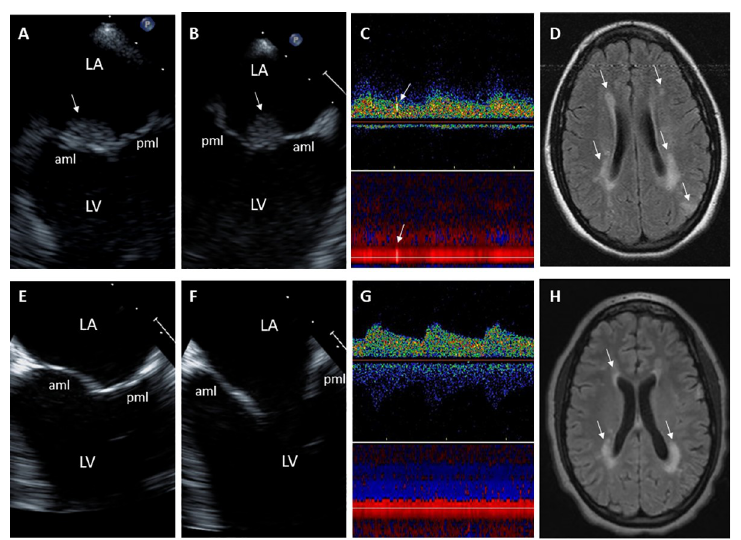
Fig 4. 18-year-old female with Libman-Sacks Endocarditis complicated with acute homonymous hemianopsia, confusional state, and cognitive dysfunction. A,B. These 2-D TEE orthogonal views ( A,B ) demonstrate a large (area of 1.3 cm 2 ), sessile, and oval shaped Libman-Sacks vegetation (arrows) on the atrial side of the anterior mitral leaflet (aml). Associated moderate mitral regurgitation was present. C . Transcranial Doppler of the right middle cerebral artery demonstrates 1 of 4 microemboli (arrows). D . Diffuse weighted imaging of the brain demonstrates bilateral periventricular cerebral infarcts (arrows) for a total lesion load of 13.71 cm 3 . Her global neurocognitive dysfunction was graded as moderate. Repeat studies after 9 weeks of warfarin, prednisone, and cyclophosphamide showed resolution of the mitral valve vegetation ( E,F ), mitral regurgitation, and cerebromicroembolism ( G ), improvement in brain lesions ( H ) with a decrease of brain lesion load to 7.72 cm 3 , and improvement in her global neurocognitive dysfunction to mild degree. Abbreviations as in previous Figure.